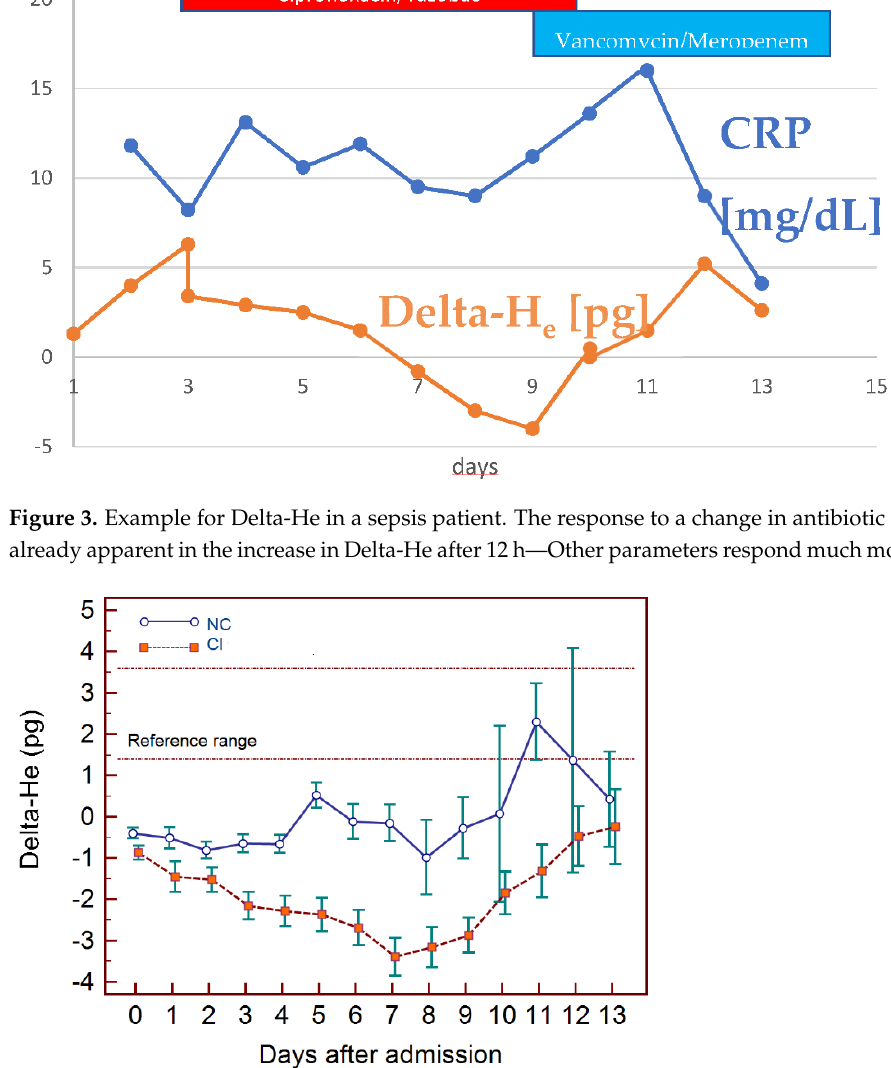
Figure 4. Delta-He in COVID-19 patients. Difference between critical (CI) and non-critical patients (NC).